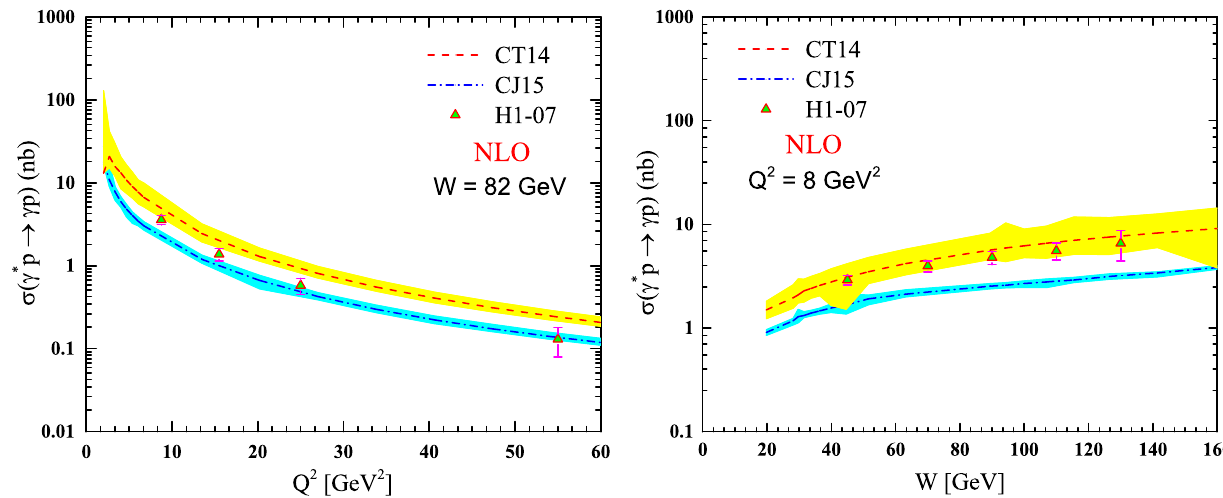
Fig. 6 The DVCS γ ∗ p → γ p cross section as a function of Q 2 (left) and W (right). Our NLO pQCD results are compared to the 2007 H1 data [78]; see for details Fig. 4